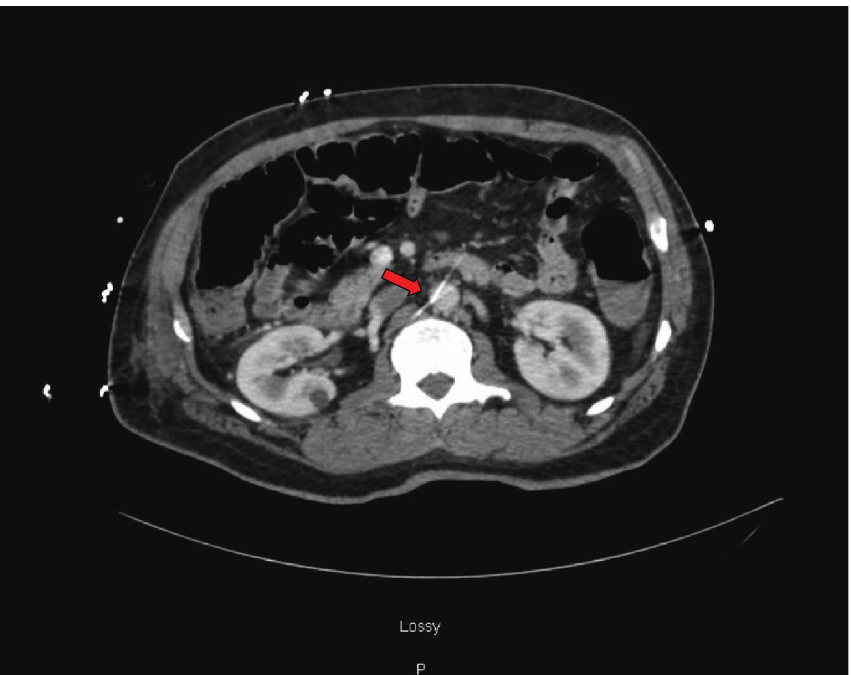
Figure 2: CT abdomen/pelvis findings showing the inferior metallic marker of the intra-aortic balloon pump below the origin of the superior mesenteric artery